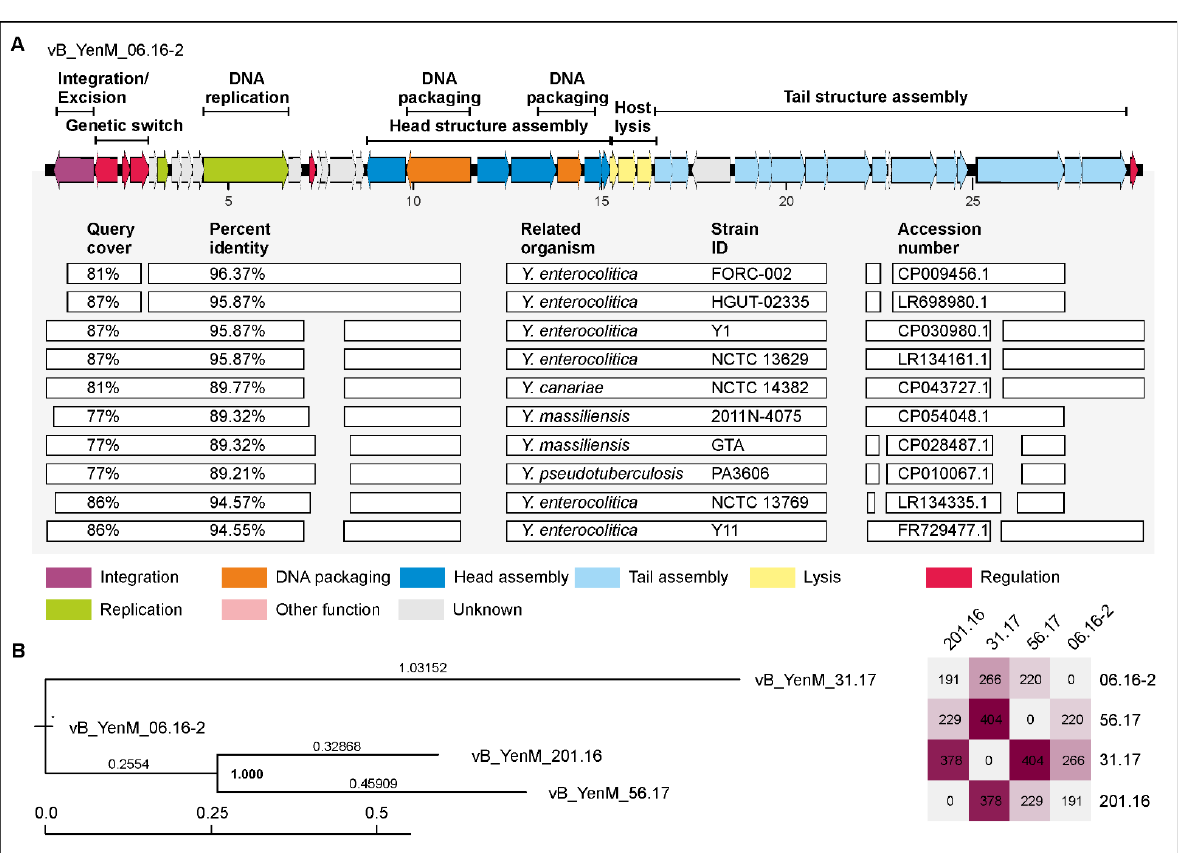
Figure 5. Gene map of vB_YenM_06.16-2 and its relationship to other prophages. ( A ) Gene map of the phage and identity values with other prophage sequences. White bars represent regions of high nucleotide similarity (>75%). ( B ) Phylogenetic tree (single nucleotide polymorphism (SNP)-based) of phages belonging to the vB_YenM_06.16-2 group. The scale bar represents the number of nucleotide substitutions per site. On the right, the number of single nucleotide variations between individual phage genomes are given.